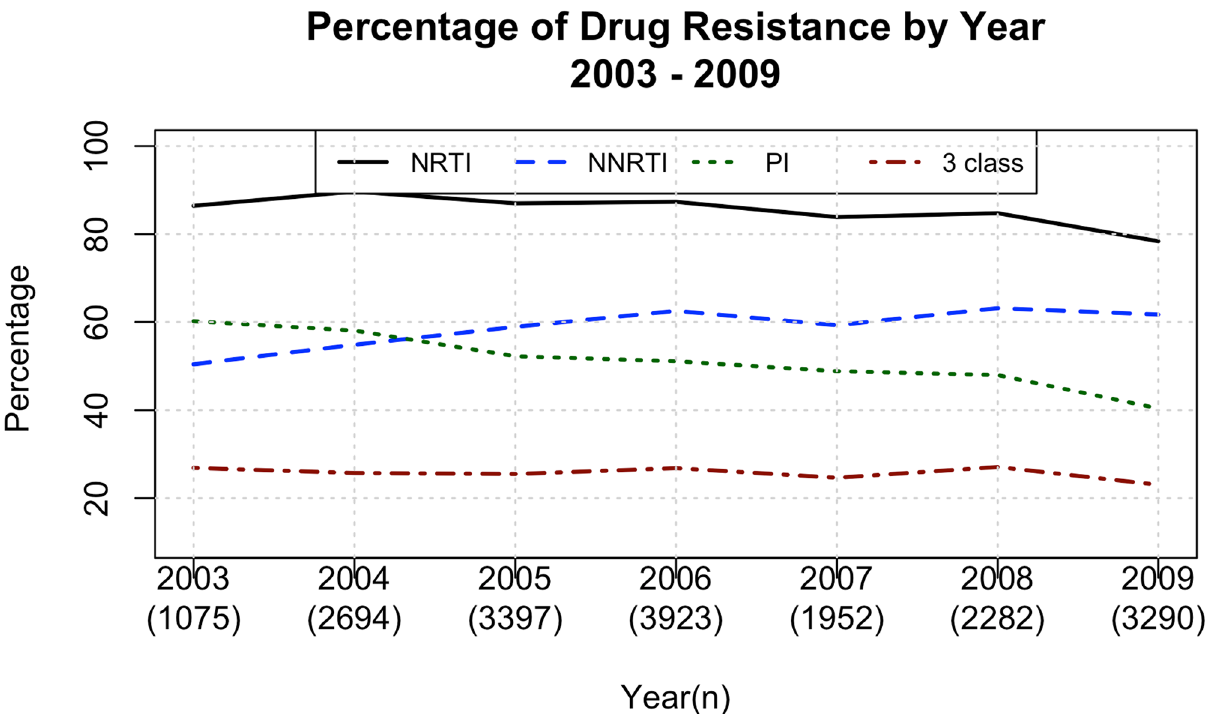
Fig 8. Antiretroviral resistance by class. Percentage of resistance to different antiretroviral classes and number of 3 class resistances among individuals in which the genotype test have been performed in Brazil from 2003 to 2009.